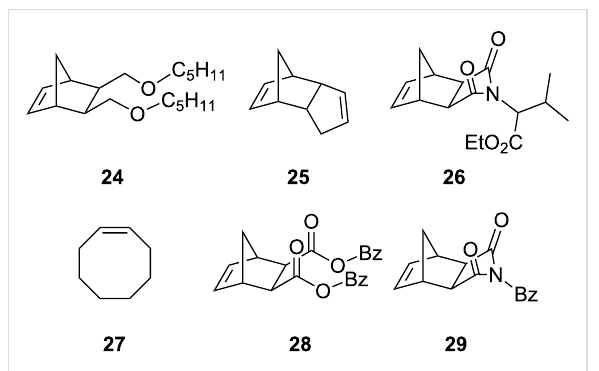
Figure 10: Different monomers for